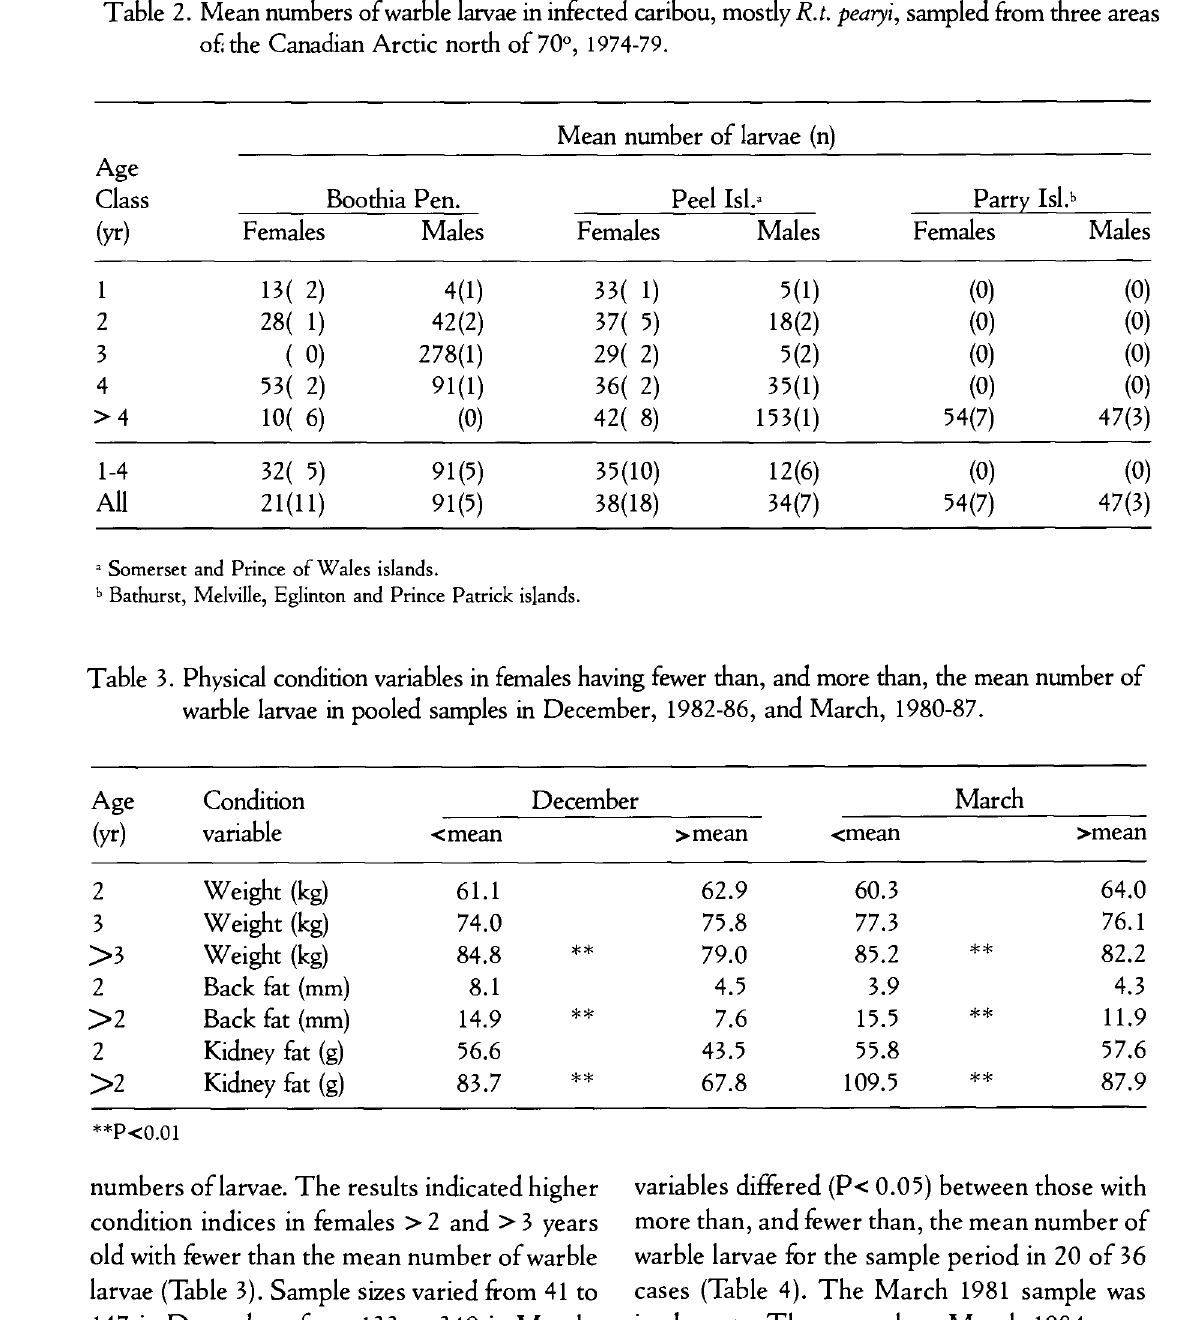
Table 2. Mean numbers of warble larvae in infected caribou, mostly R.t. pearyi, sampled from three areas of the Canadian Arctic north of 70°, 1974-79.